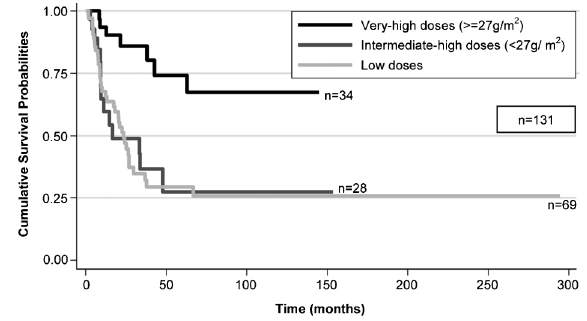
Figure 5. Event-free survival of patients consolidated with cytarabine, by total dose administered. P , 0.001, comparing different doses (log-rank